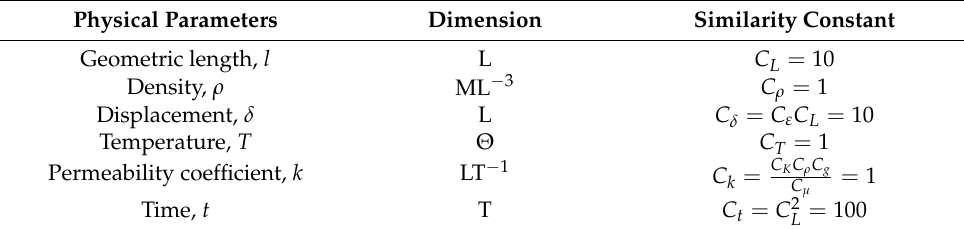
Table 3. Similarity ratio.